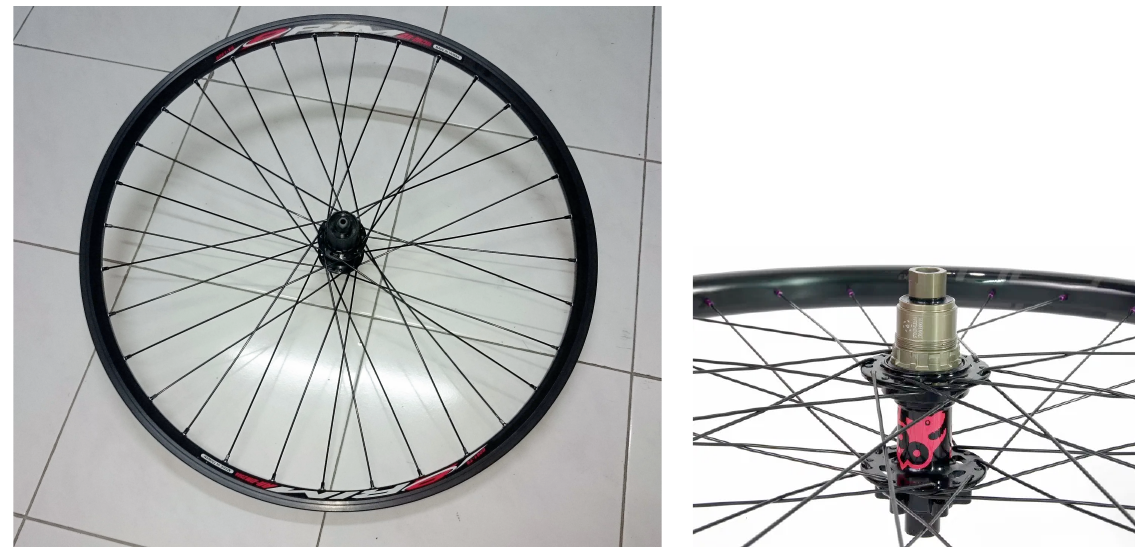
Figure 52. A bicycle wheel is a body-bar framework in 3-dimensions, but with spokes that can only sustain tension. E of a body-bar framework is a subset E (cid:48) of edges whose removal A cut set S ⊂ separates the graph of the framework into two or more distinct components. The